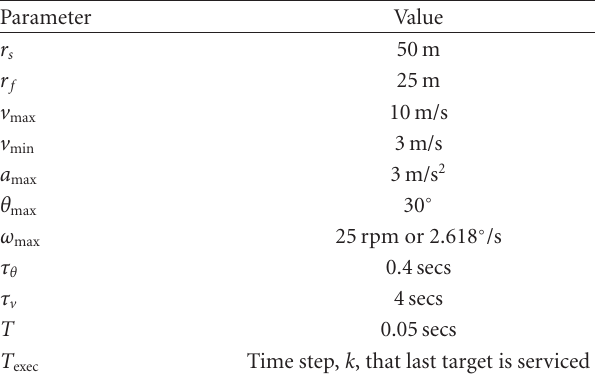
Table 2: UAV and simulation